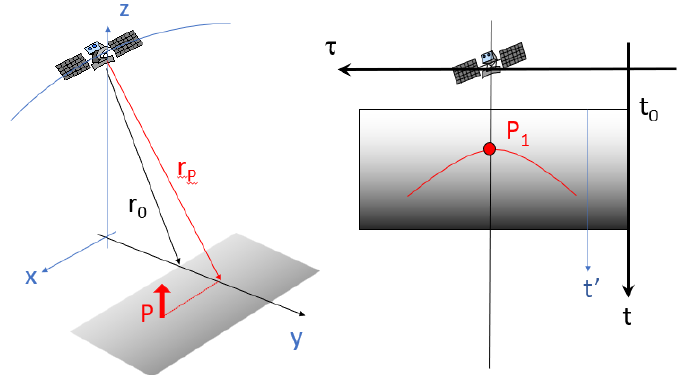
Figure A1. Representation of the geometry of the LEO SAR acquisition in the curved orbit case ( left ), and for the raw data ( right ). The orbit curvature has been exaggerated.